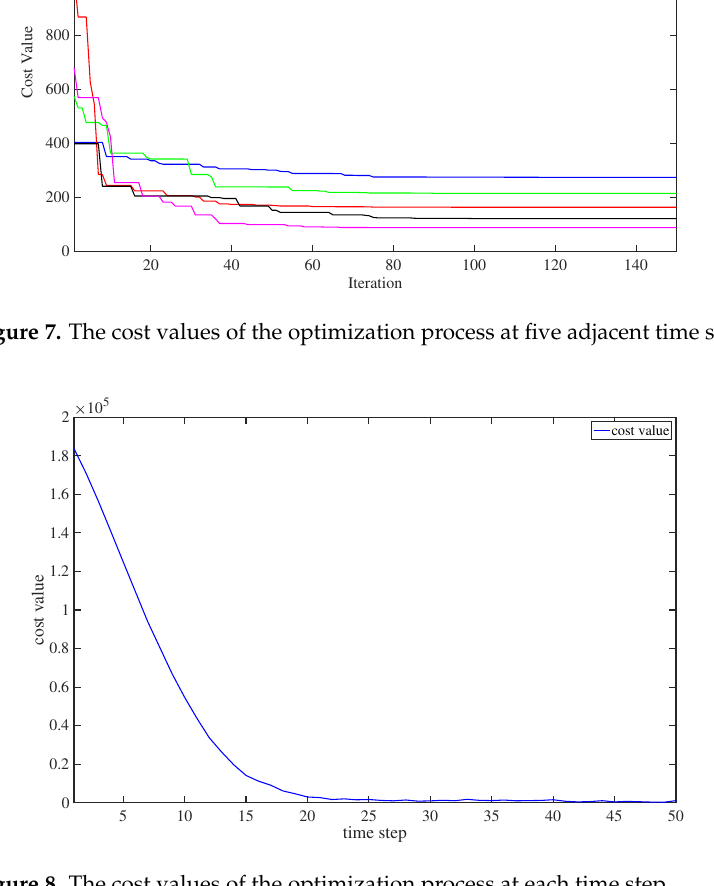
Figure 8. The cost values of the optimization process at each time step. Figures 9 and 10 depicts the tracking performance of different controllers, while Table 3 indicates the state error of different controllers. The findings illustrate that both controllers could efficiently control the system.